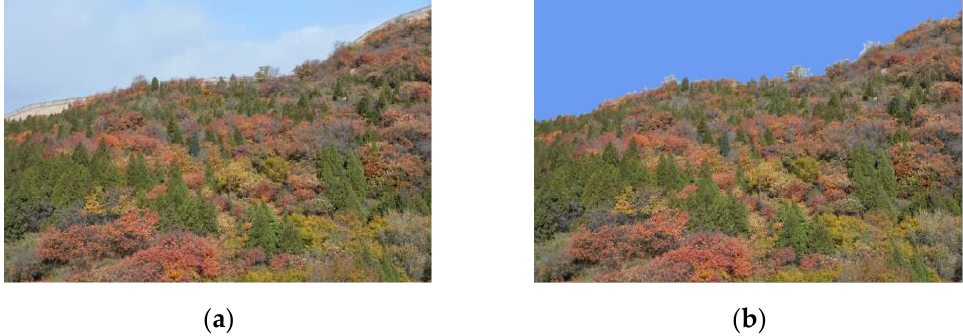
Figure A2. The sample of original photograph and processed one. ( a ) The original landscape photograph; ( b ) the photograph after color replacement.